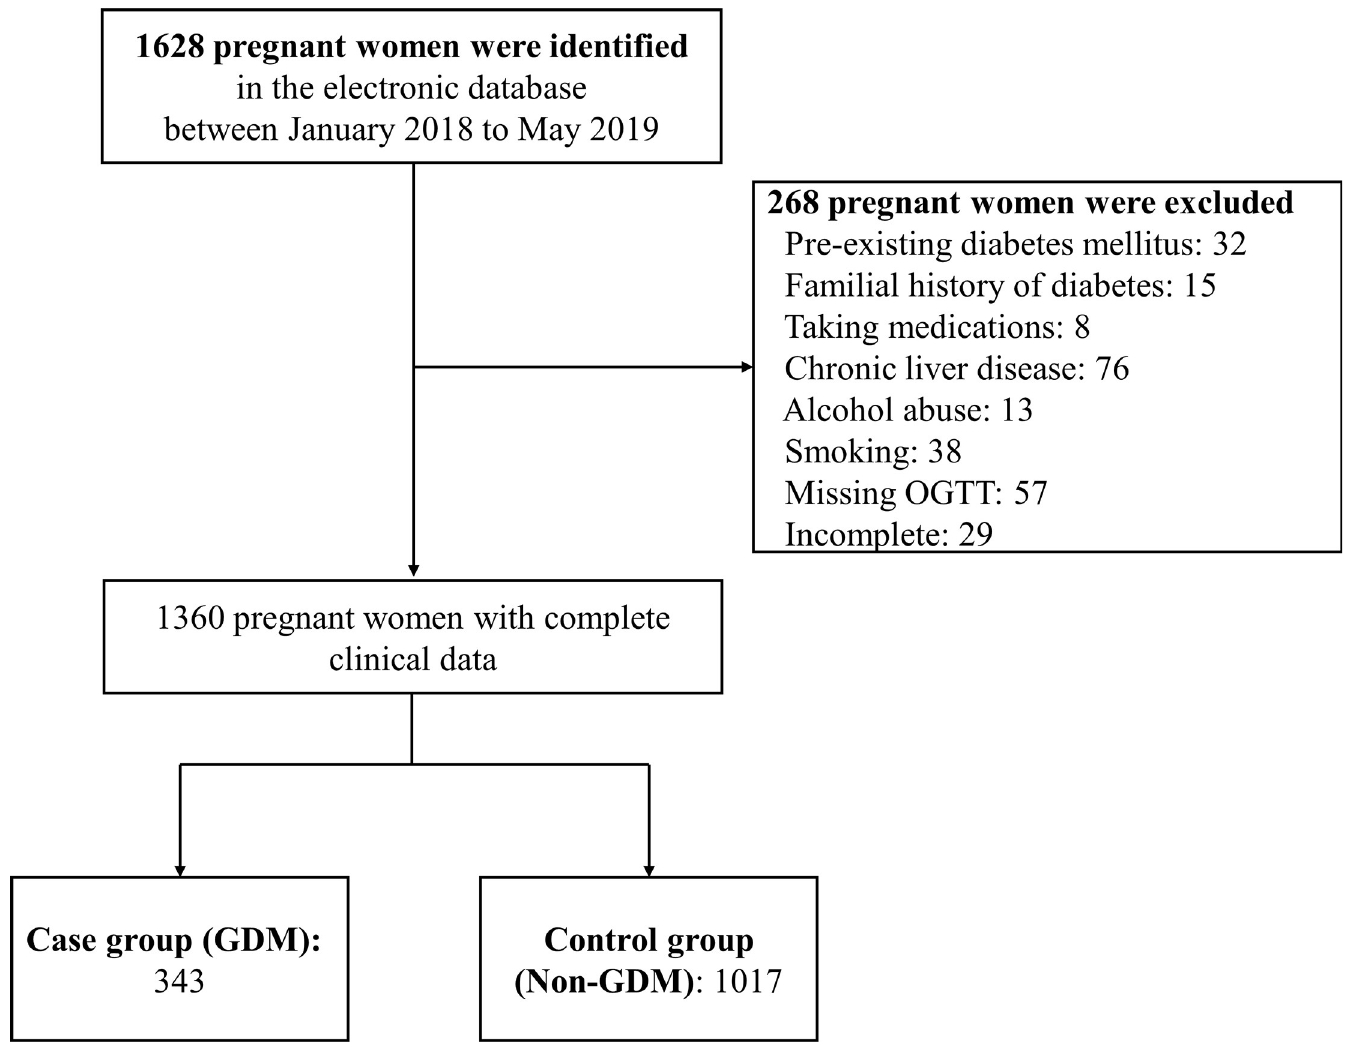
Fig 1. Flow chart of the study